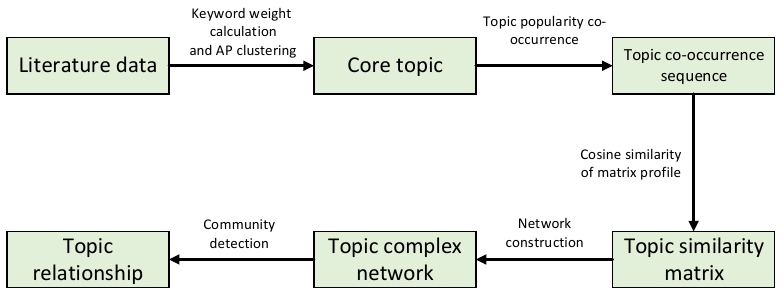
Figure 1. Research